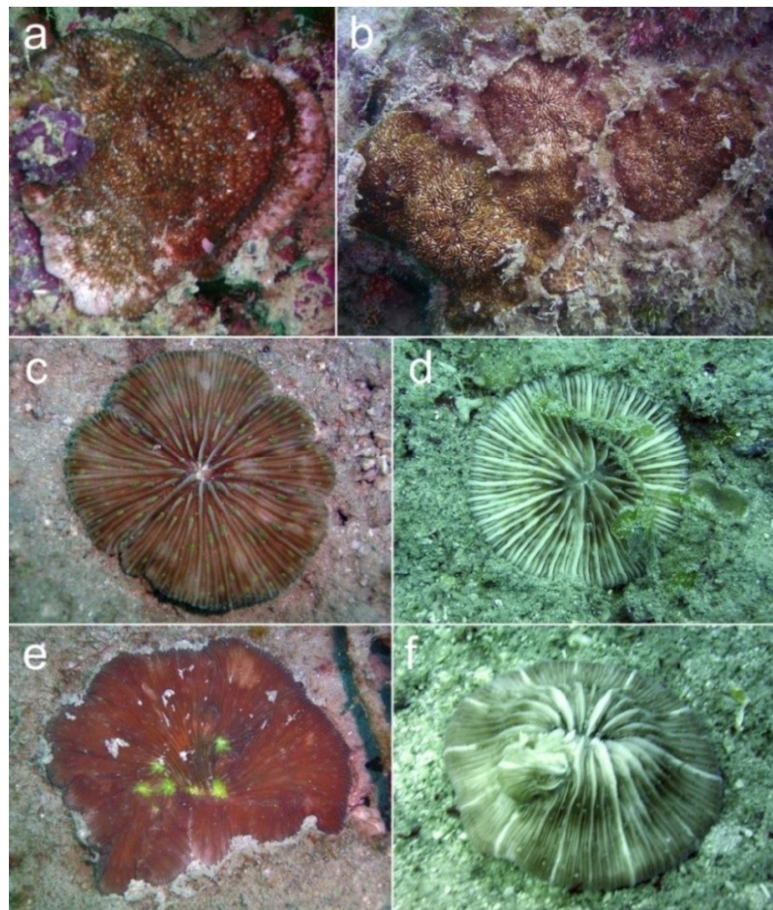
Figure 6. Cycloseris corals, encrusting on lower-slopes ( a,b ) and free-living on reef-bases ( c–f ) in zones 2–3: ( a ) C. explanulata at E Pulau Pari; ( b ) C. mokai at NW Pulau Hantu Kecil; ( c ) C. fragilis (self-fragmenting) at NW Pulau Peniki; ( d ) C. fragilis (complete) at NW Pulau Tidung Besar; ( e ) C. sinensis (self-fragmenting) at NW Pulau Peniki; ( f ) C. vaughani at E Karang